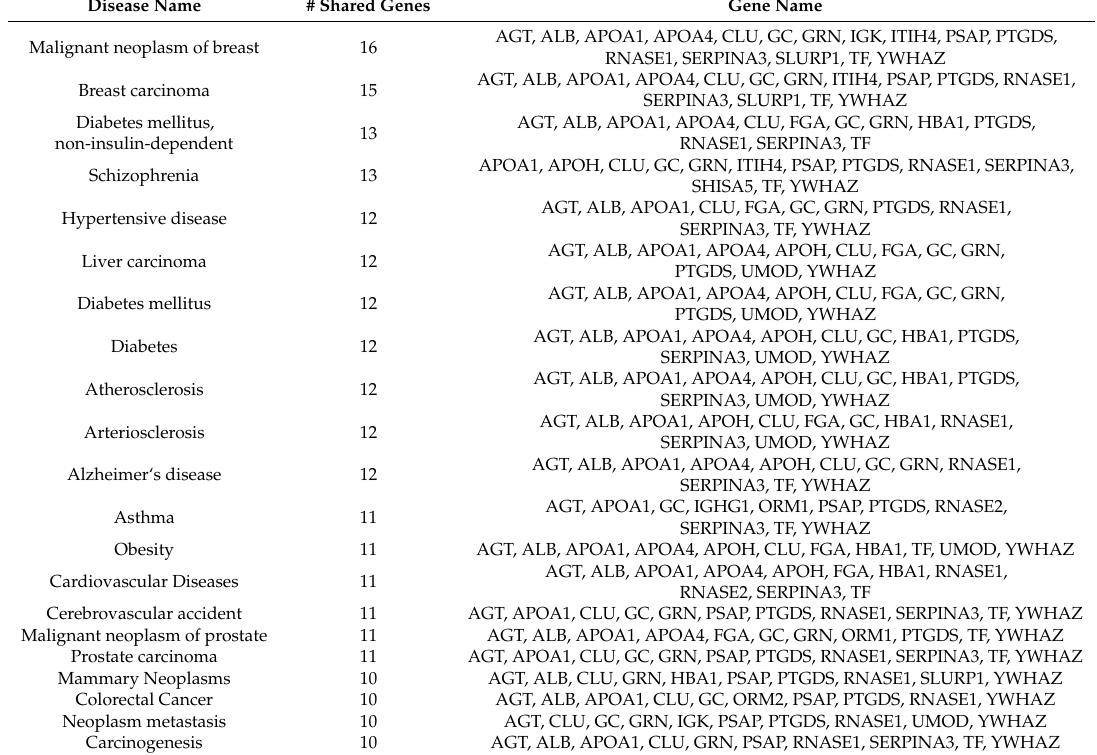
Table 2. DisGeNET disease analysis for the naïve group.